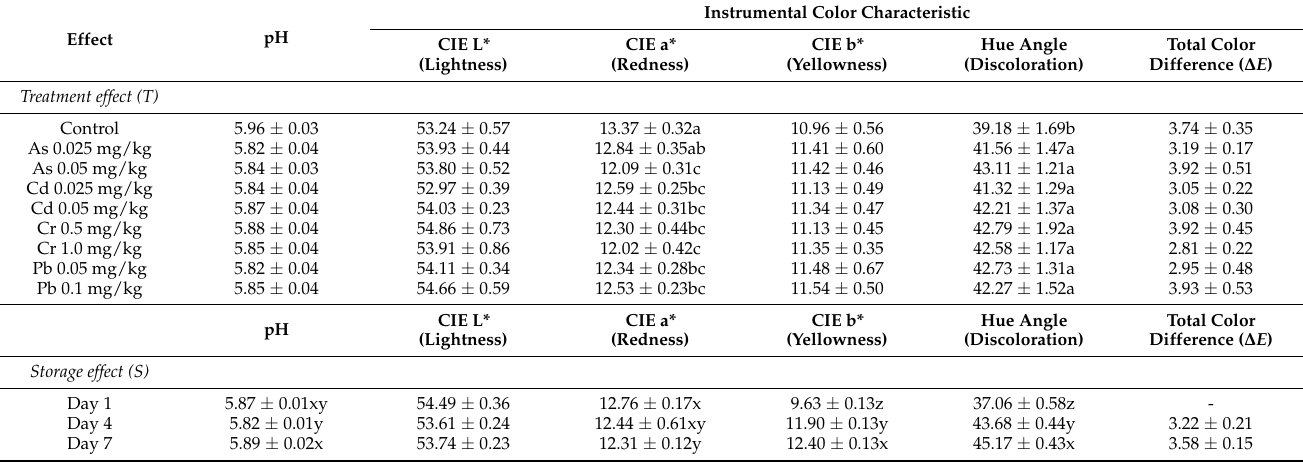
Table 3. pH and instrumental color changes in ground pork intentionally contaminated with toxic heavy metals during 7 days of aerobic display